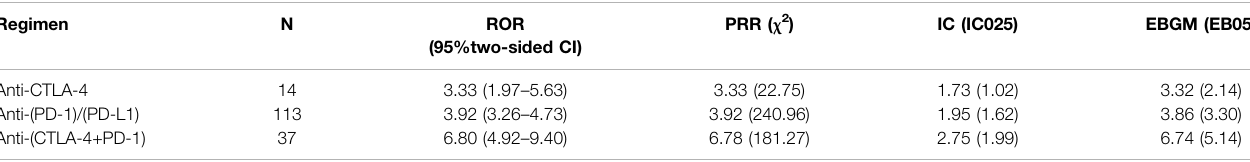
TABLE 4 | Detected signals of TLS related to ICIs by four algorithms.